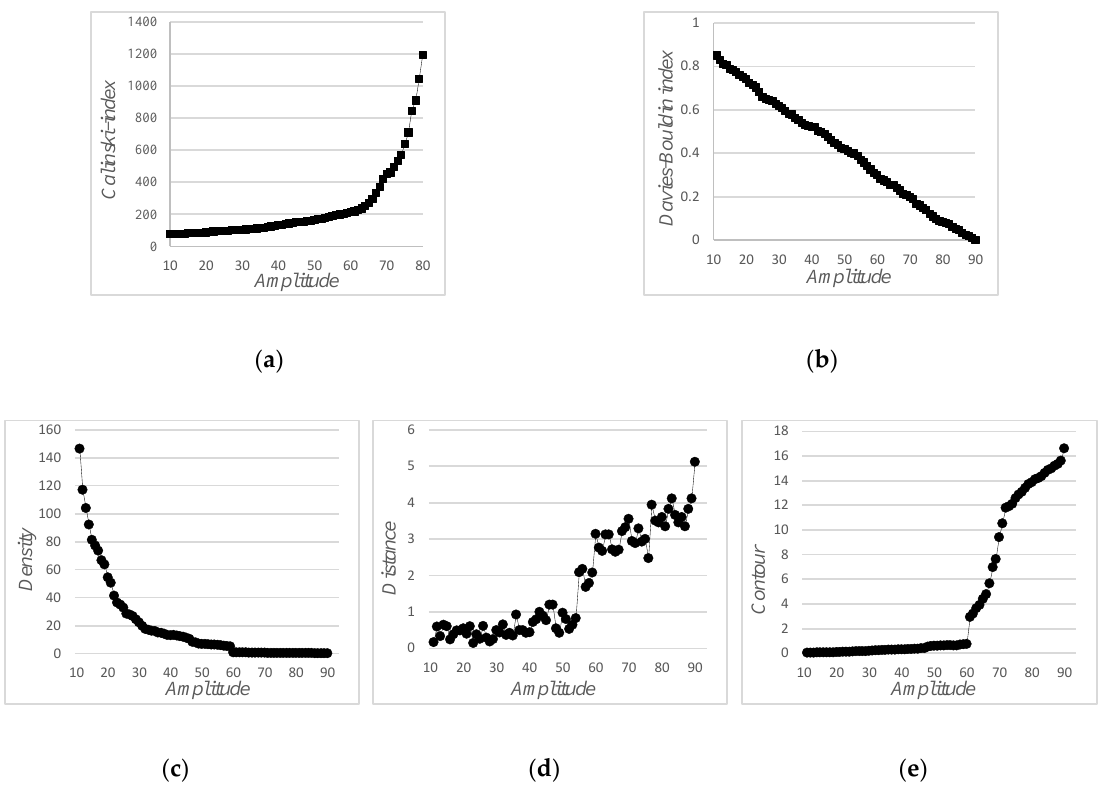
Figure 10. Follow-up of the detected cluster: evolution of ( a ) Calinski index, ( b ) Davies–Bouldin index. ( c ) Density, ( d ) distance and ( e ) contour.